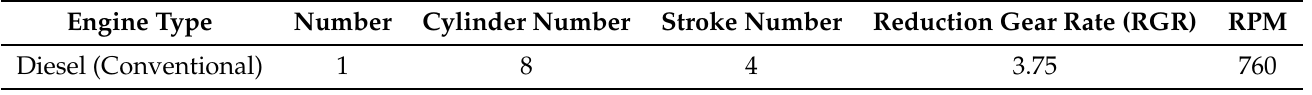
Table 3. The parameters of the ship’s engine.